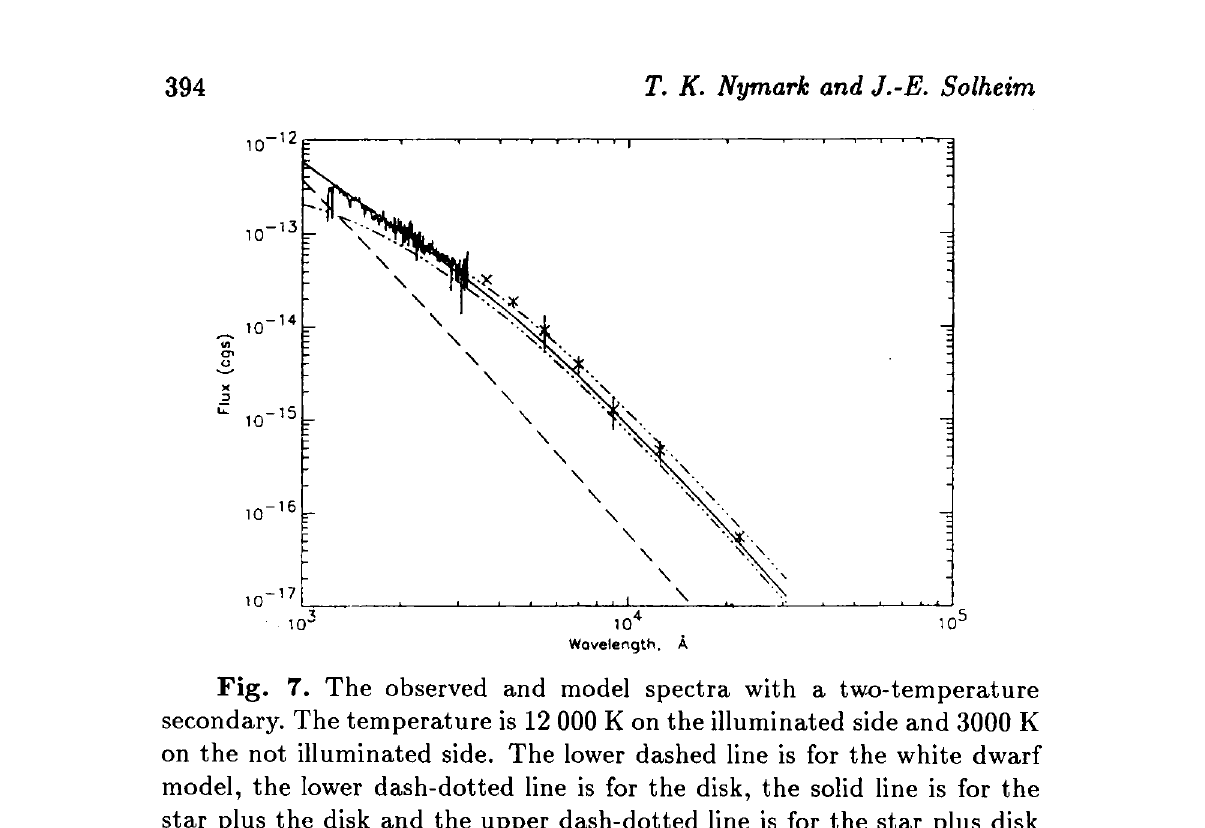
Fig. 7. The observed and model spectra with a two-temperature secondary. The temperature is 12 000 K on the illuminated side and 3000 K on the not illuminated side. The lower dashed line is for the white dwarf model, the lower dash-dotted line is for the disk, the solid line is for the star plus the disk and the upper dash-dotted line is for the star plus disk and plus a secondary object with the effect of